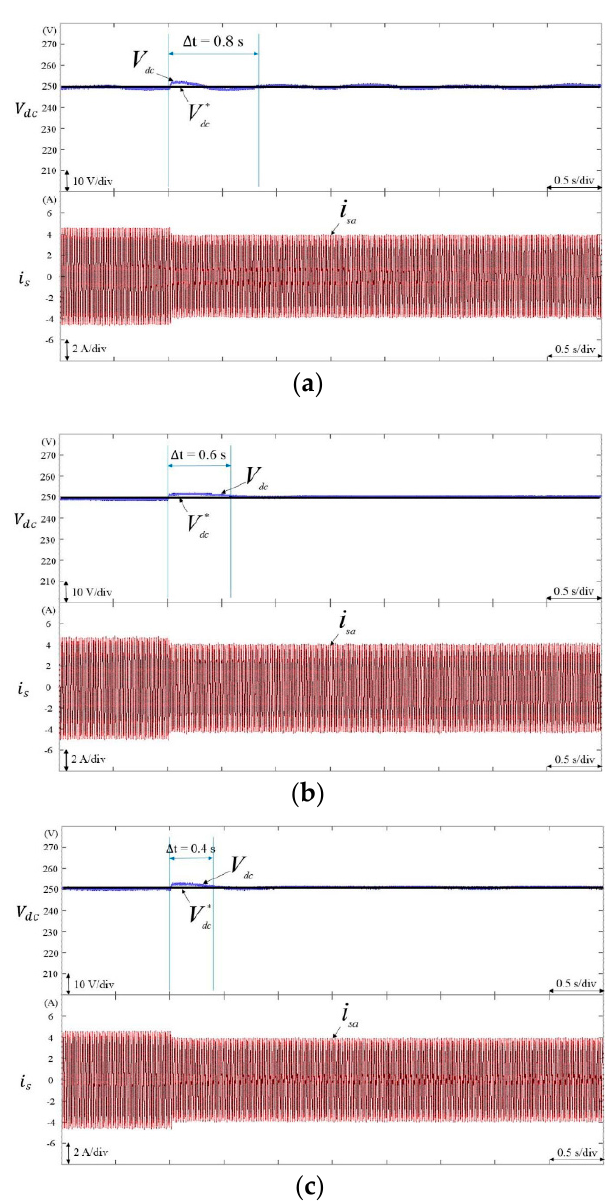
Figure 9. Experimental results at case 2: ( a ) Responses of DC-link voltage V dc and grid current i sa using PI controlled DSTATCOM; ( b ) Responses of DC-link voltage V dc and grid current i sa using CFNN controlled DSTATCOM; ( c ) Responses of DC-link voltage V dc and grid current i sa using proposed CFNN-AMF controlled DSTATCOM. Table 4. Response time of DC-link voltage and regulation voltage error for different controllers at case 2.